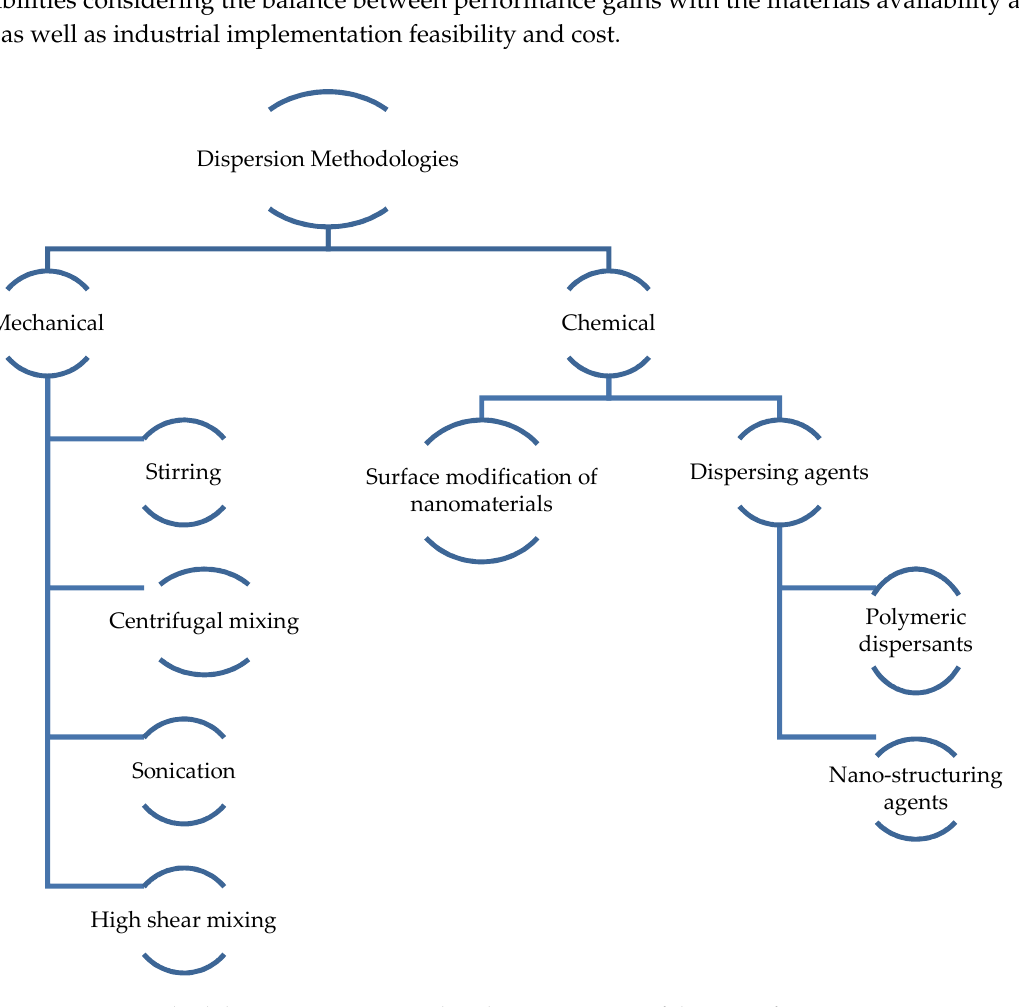
Figure 3. Methodologies to improve the dispersion or exfoliation of nanostructures into polymeric matrices.